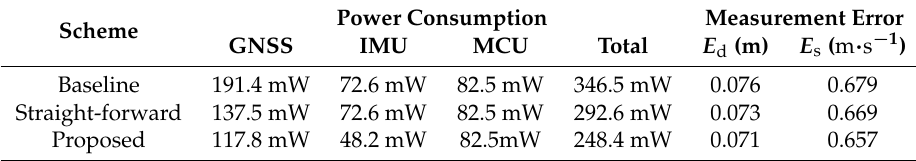
Table 7. Performance of different firmware